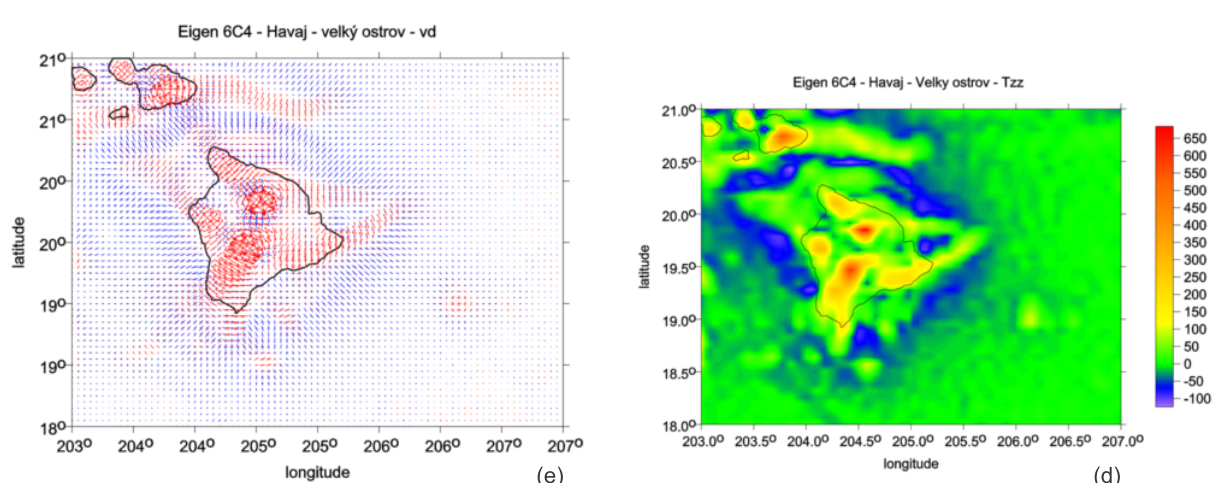
for all the islands; (b) the Big Island, taken from © Google Earth; then for the Big Island alone (c) D g , (d) T Figure 4. Hawaii: (a) T zz (e) vd